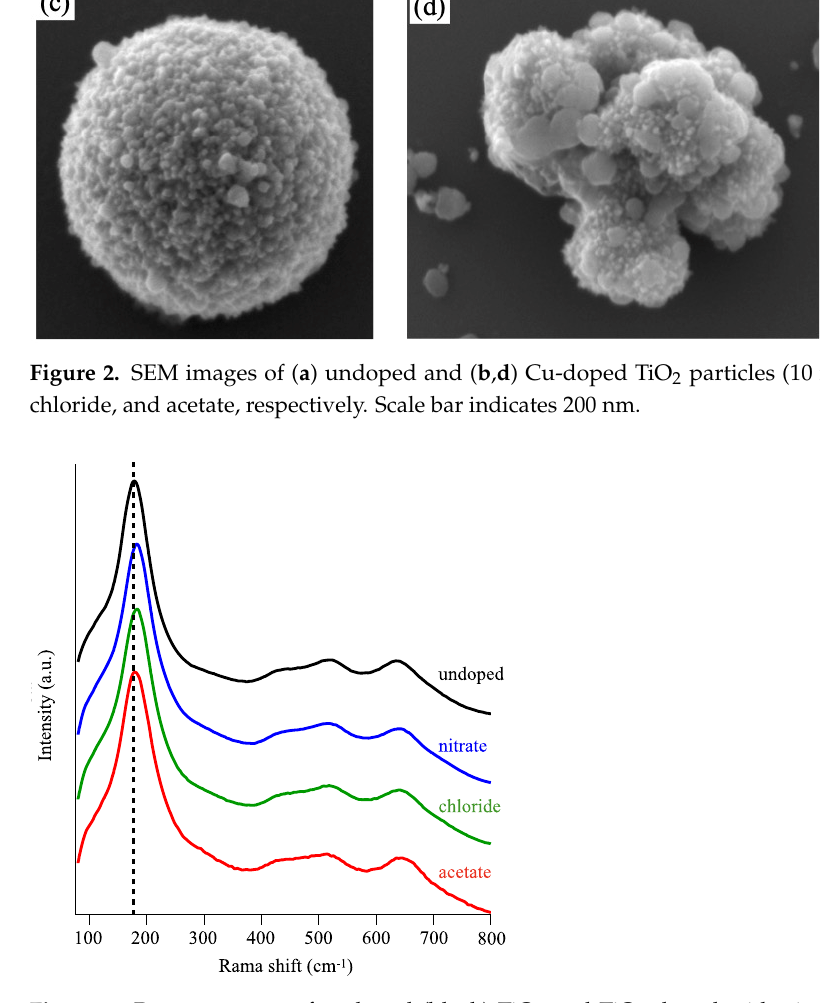
Figure 3. Raman spectra of undoped (black) TiO 2 and TiO 2 doped with nitrate (blue), chloride (green), and acetate (red). The spectral intensity was normalized. Table 1. Dependence of FWHM values on Cu salt species.